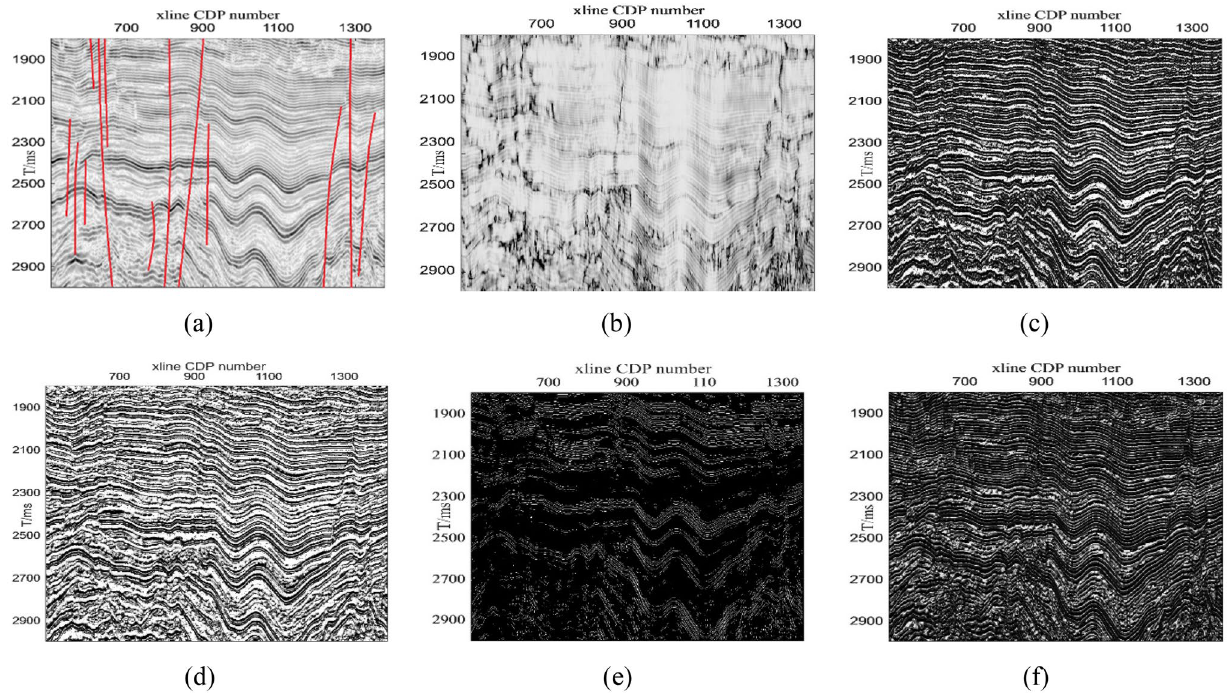
Fig. 5 Results of the actual seismic profile test a Original picture and results obtained by the b coherence operator; c LBP/VAR method; d median filtering-LBP/VAR method; e guided filtering-Canny method; and f guided filtering-LBP/VAR